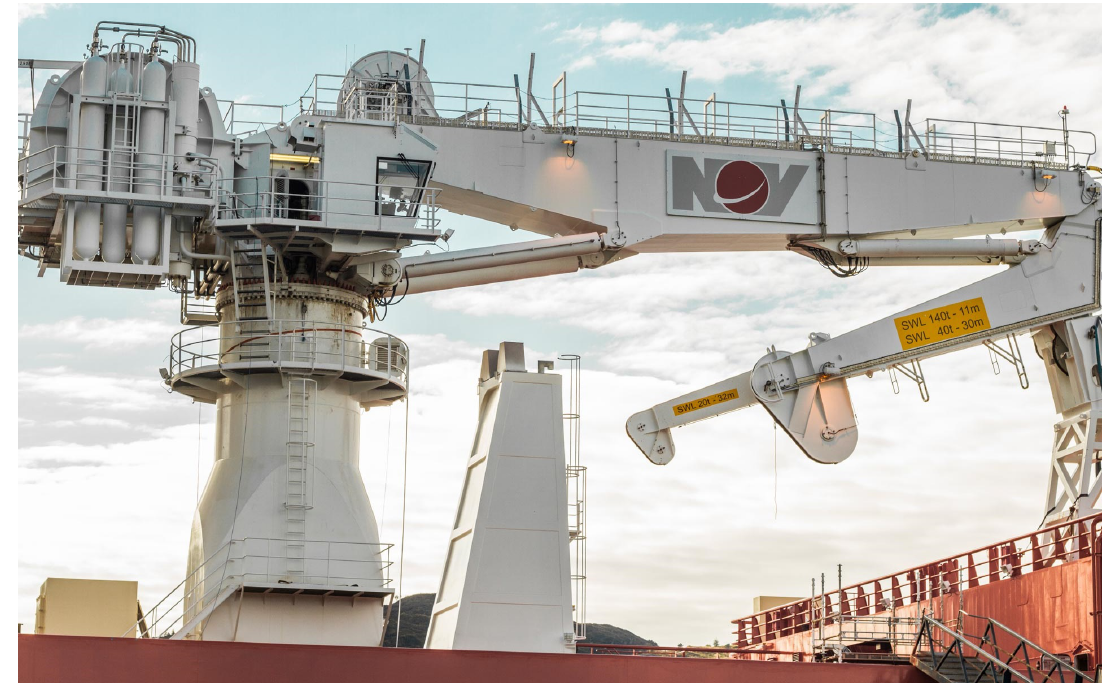
Figure 1. Typical offshore knuckle boom crane, courtesy of National Oilwell Varco c (cid:13)